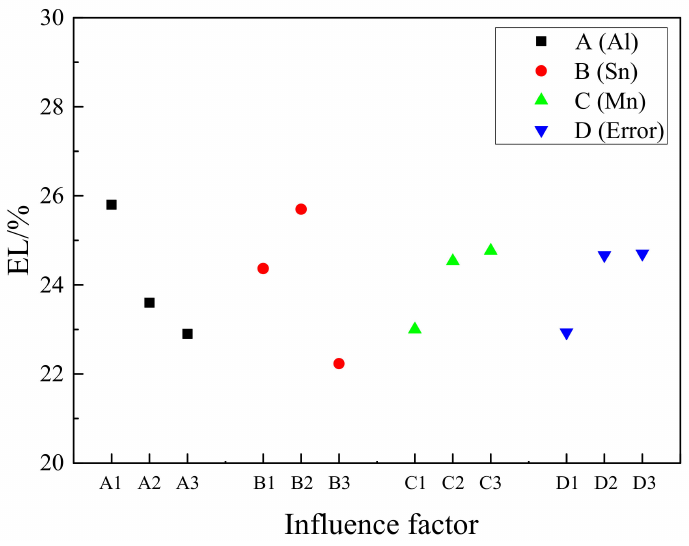
Figure 13. Factors and Index trends diagram of elongation for nine trial